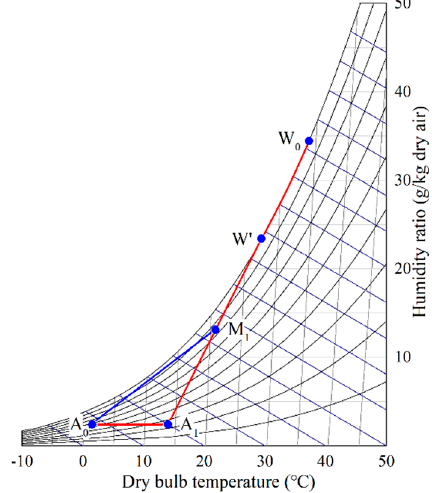
Figure 6. Principle of coupling technology.